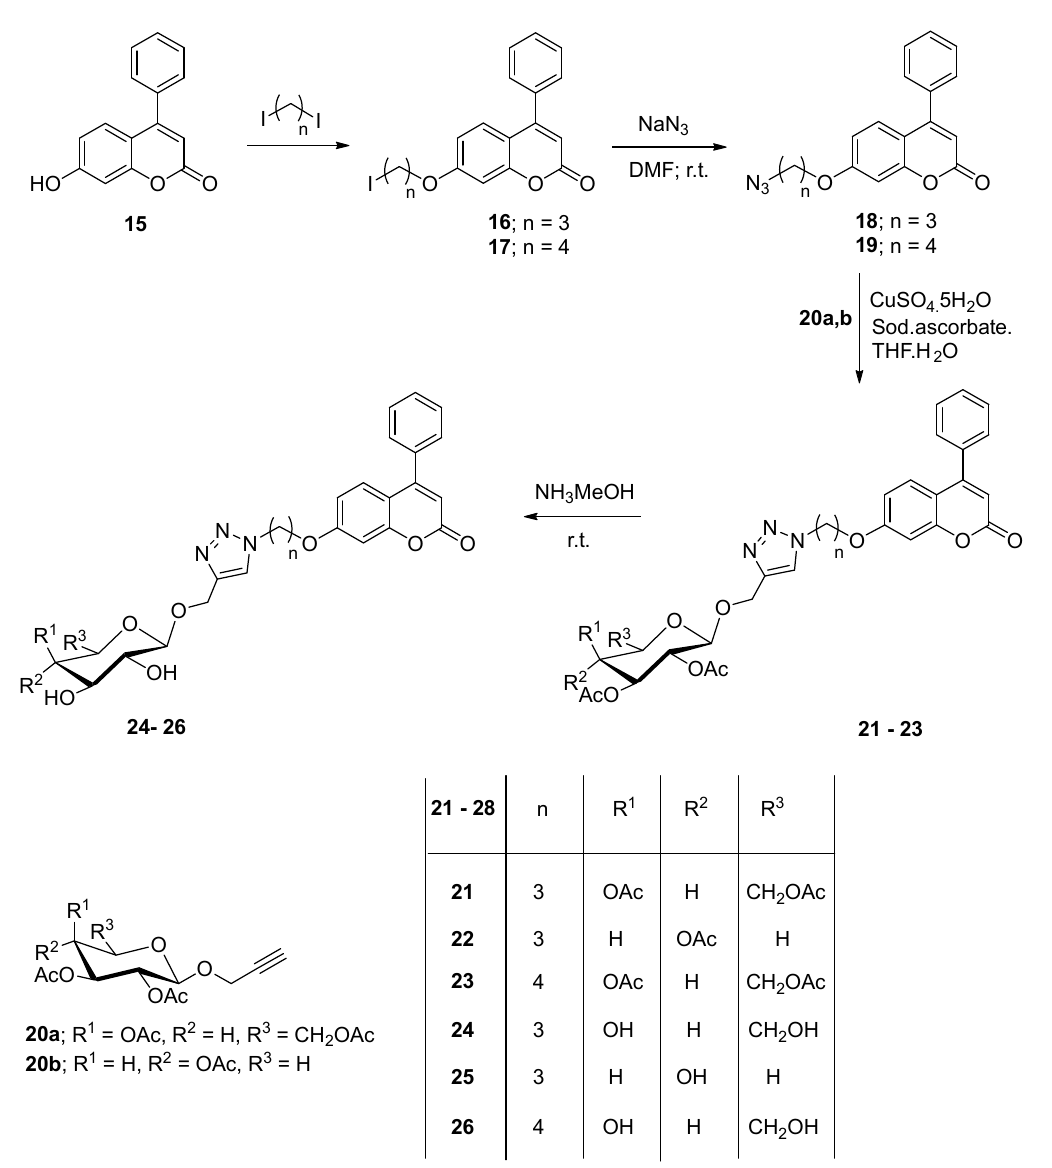
Scheme 2: Synthesis of 1,2,3-triazol-coumarin hybrdid